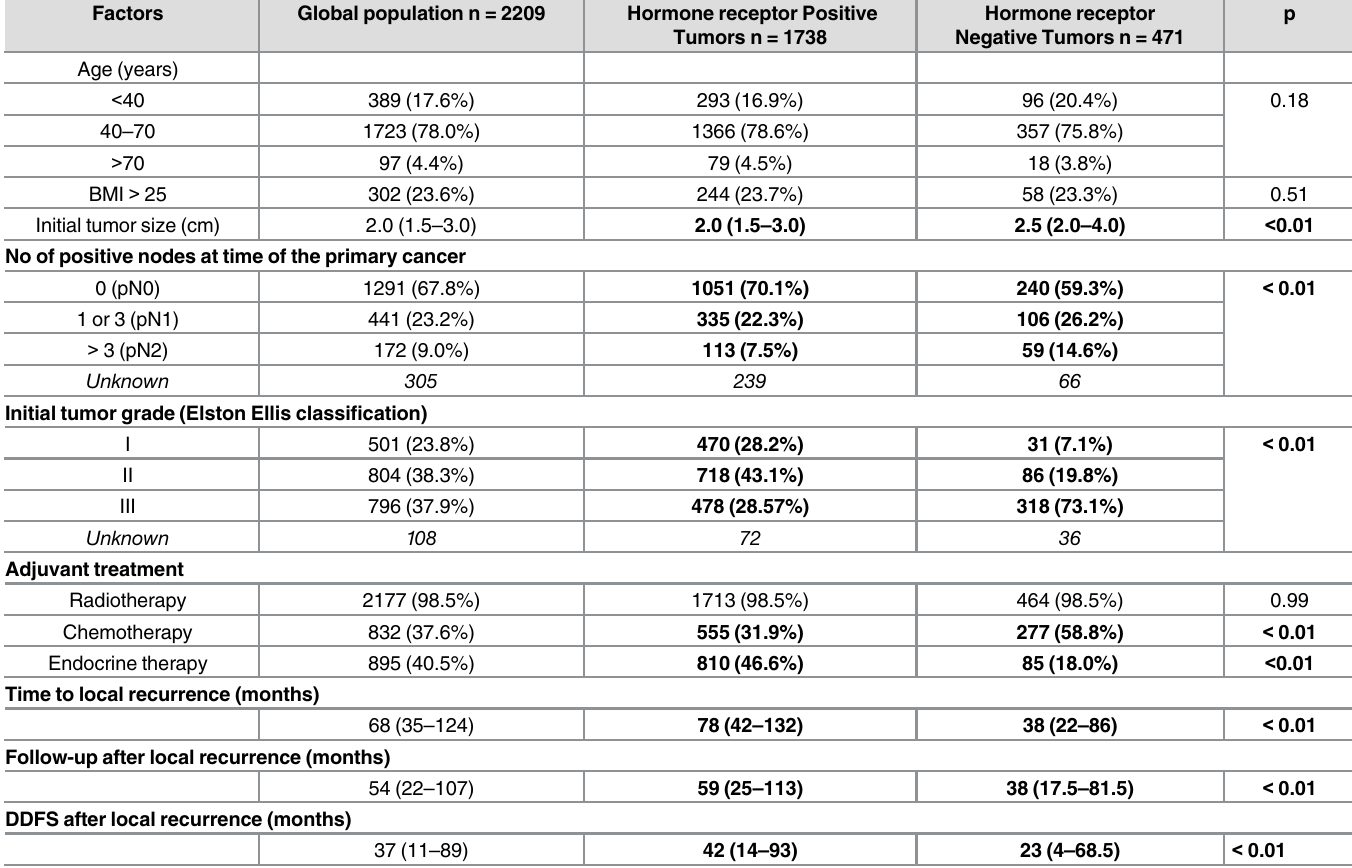
Table 1. Initial characteristics of the population with ipsilateral Breast Cancer Recurrence, at time of primary